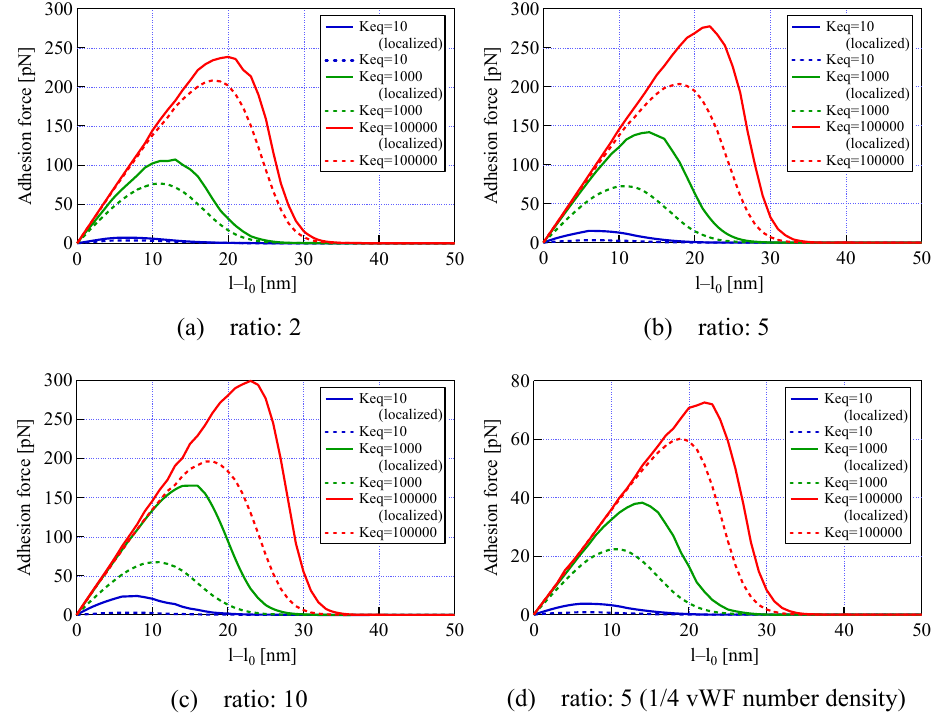
Fig. 7 Profiles of the adhesion force between a platelet and vessel wall. (Parameter values are shown in Table 1)